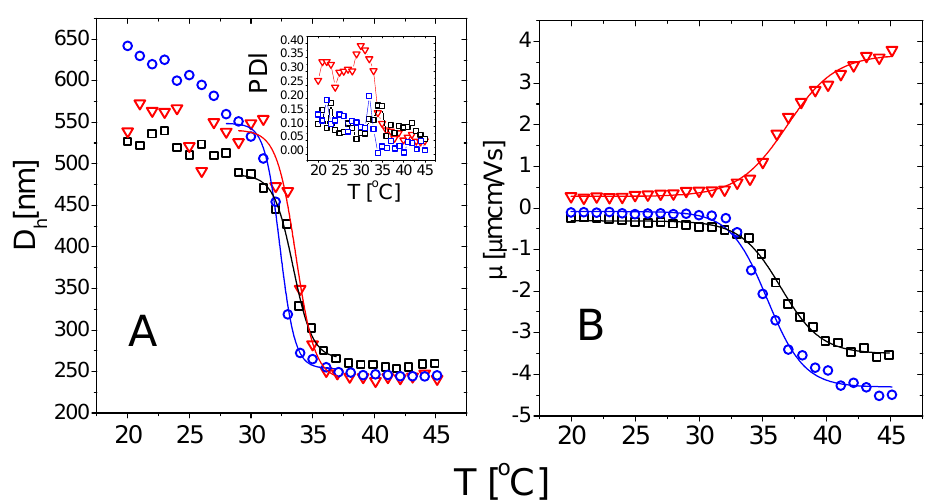
Figure 3. Hydrodynamic diameter (Panel A ) and electrophoretic mobility (Panel B ) of m1-KPS (circles), m5-KPS (squares) and m5-AIBA (triangles) microgels in water as a function of temperature. Solid lines are fits obtained using Boltzmann functions as detailed in the text. The inset (Panel A ) shows the polydispersity index (PDI) obtained via a cumulant analysis of the intensity autocorrelation functions g 2 ( τ ) − 1 for the three microgel